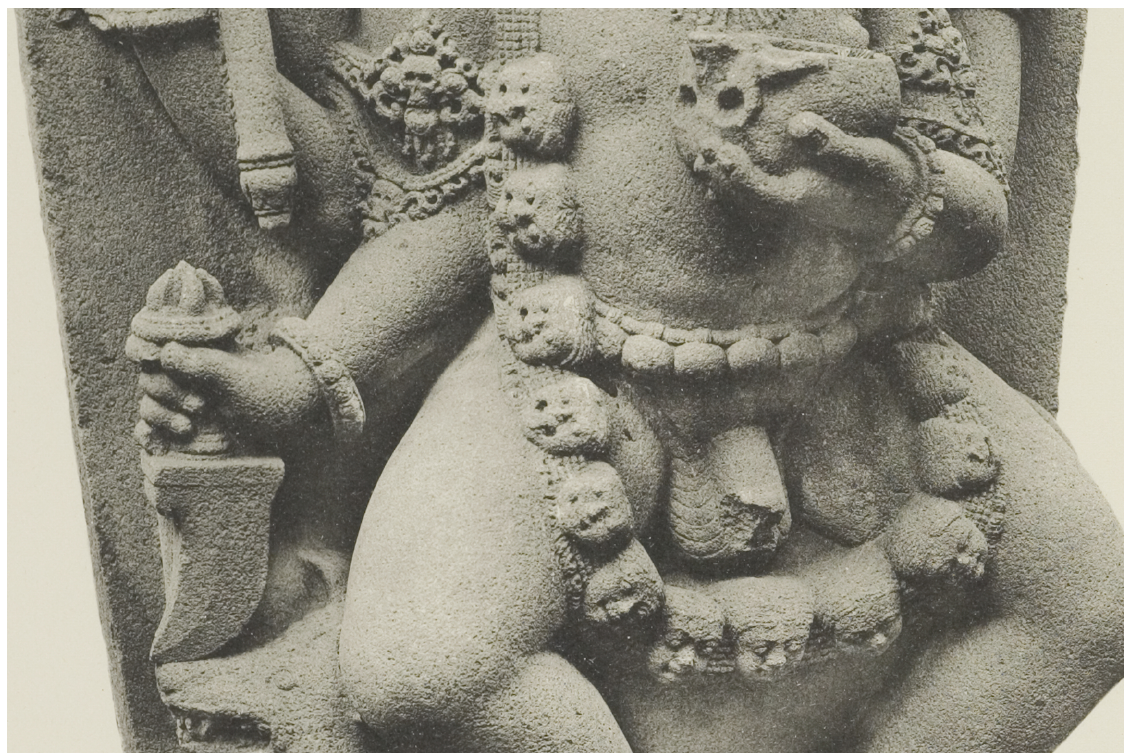
Figure 9 Vajra-handled cleaver (left) and skull (right) held by Cakracakra, Candi Singosari, Eastern Java (detail). Siṅhasāri period. Licence: CC BY 4.0. Source: Leiden University Libraries shelfmark KITLV